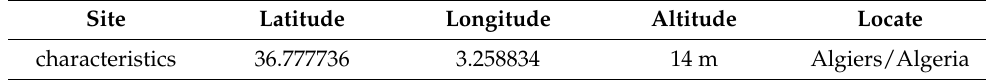
Table 2. Geographical characteristics of the site of implantation.